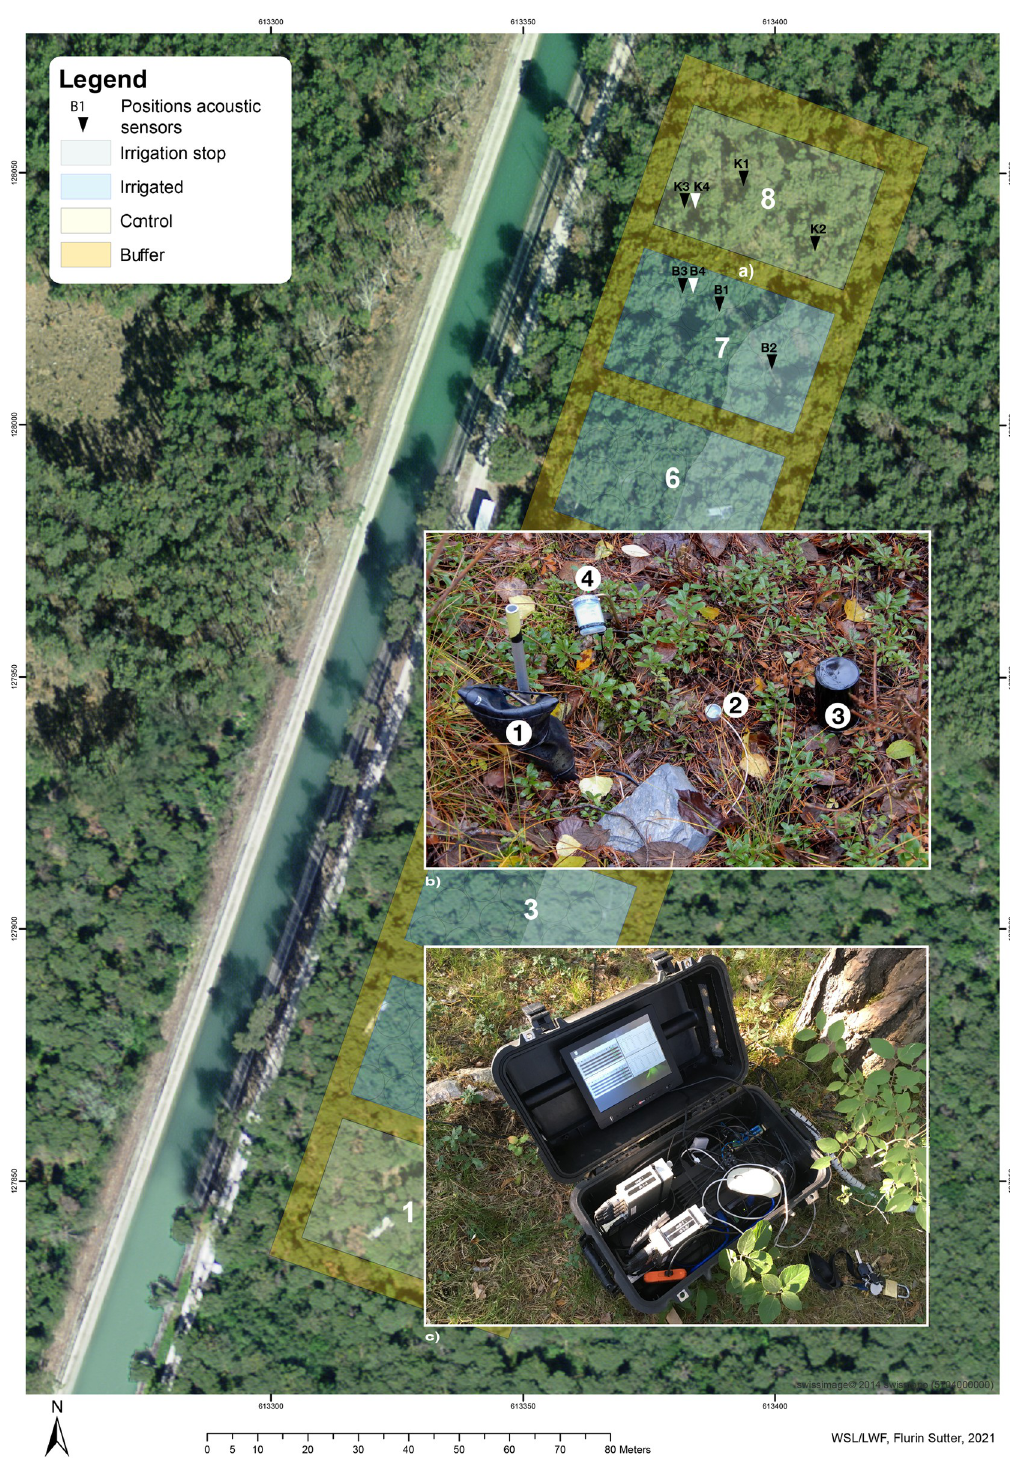
Fig 1. a) Acoustic sensors marked with black triangles are located at plots 7 (irrigated/irrigation stop) and 8 (control) of the irrigation experiment in Pfynwald, Valais, Switzerland; white triangles are control sensors in the air. b) Local setup of acoustic and microclimatic sensors: 1 acoustic sensor; 2 preamplifiers; 3 soil moisture and temperature; 4 surface temperature and light intensity. c) Case with computer and audio interfaces. Adapted from the map of the irrigation project Pfynwald (Orthomosaic © 2019 WSL, swissimage © 2014